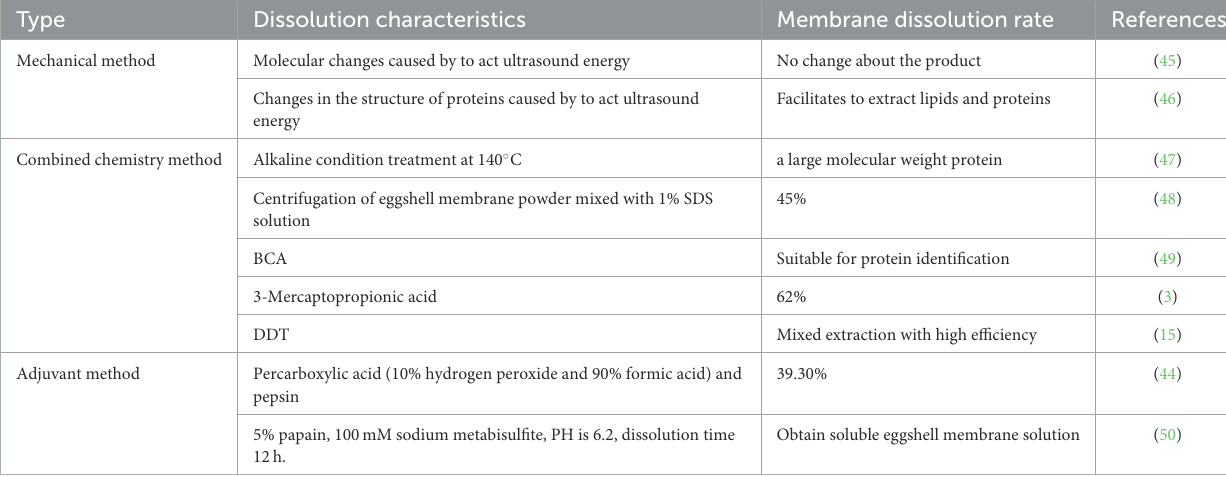
TABLE 3 Statistics of typical eggshell membrane dissolution